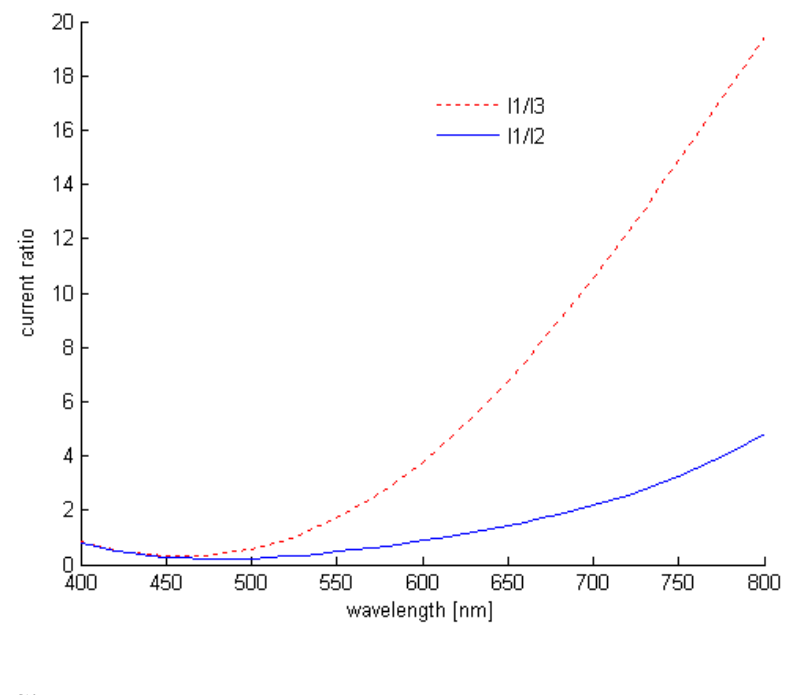
Figure 3. Photocurrent ratios vs. wavelength